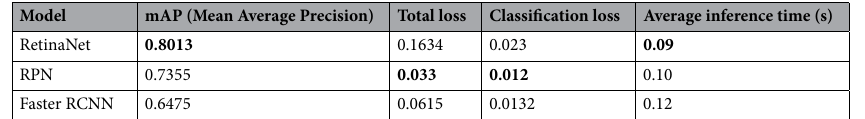
Table 1. Comparison of mean average precision, losses, and average inference time of different models on the fluorescence image dataset.